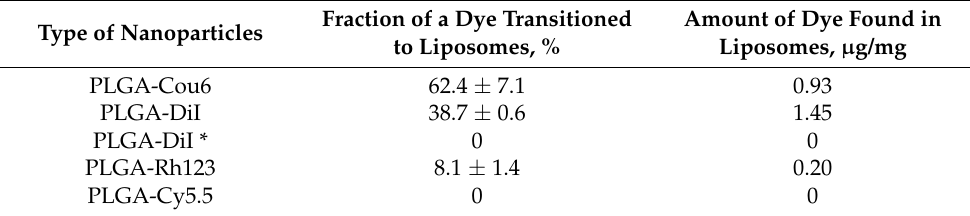
Table 2. Dye partitioning in